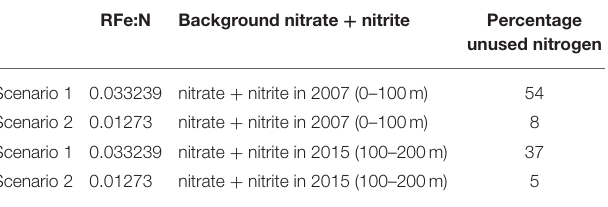
TABLE 3 | The unused nitrogen due to Fe-limitation calculated for the different RFe:N in mmol mol − 1 as used in scenario 1 and 2 as percentage of two different estimates of background of the sum of nitrate and